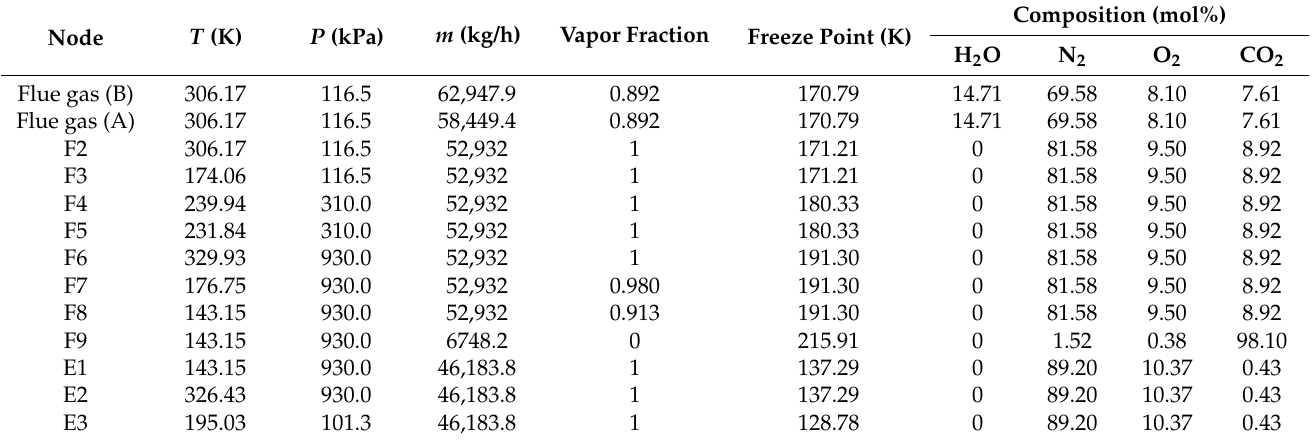
Table 4. Simulation results of flue gas and exhausted gas in System A and System B.